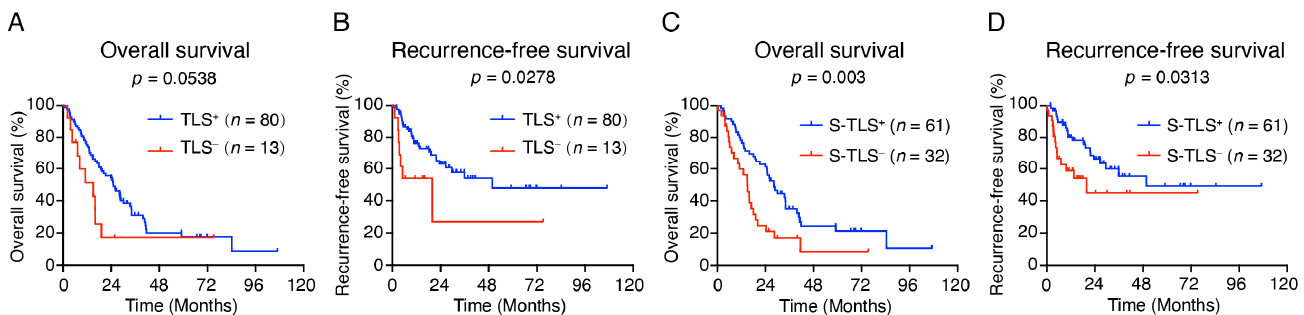
Figure 3. Impact of TLSs on OS and RFS in patients with pCCA. ( A , B ) Kaplan–Meier curves show the comparison of OS (( A ), p = 0.0538) and RFS (( B ), p = 0.0278) in patients with pCCA according to the presence or absence of TLSs. ( C , D ) Kaplan–Meier curves show the comparison of OS (( C ), p = 0.003) and RFS (( D ), p = 0.0313) in pCCA patients according to the presence or absence of S-TLSs.